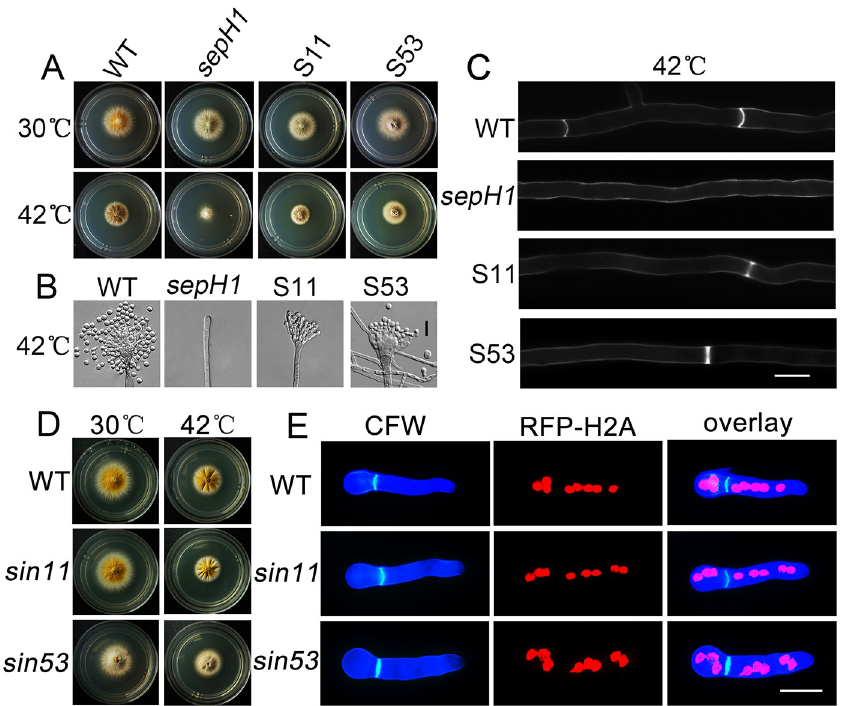
Fig 1. Septation and conidiation were partly rescued in S11 and S53 compared to the sepH1 mutant at 42 ˚C. (A) Colony morphologies of the wild type (R21), sepH1 , S11 and S53 strains cultured on YUU at 30 or 42 ˚C for 2 days. (B) Conidiophores for the conidia of the wild type (R21), sepH1 , S11 and S53 strains. Bars, 10 μ m. (C) Comparison of septum formation in hyphal cells of the wild type (R21), sepH1 , S11 and S53 strains cultured on liquid medium YUU at 42 ˚C for 20 h. Bars, 10 μ m. (D) Colony morphologies of the wild type (R21), sin11 and sin53 strains cultured on YUU at 30 or 42 ˚C for 2 days. (E) Morphological comparison of hyphal cells labeled with an RFP-histone H2A tag showing nuclei distribution and stained with CFW showing septa in relative strains cultured in liquid medium YUU at 42 ˚C for 7.5 h. Bars, 10 μ